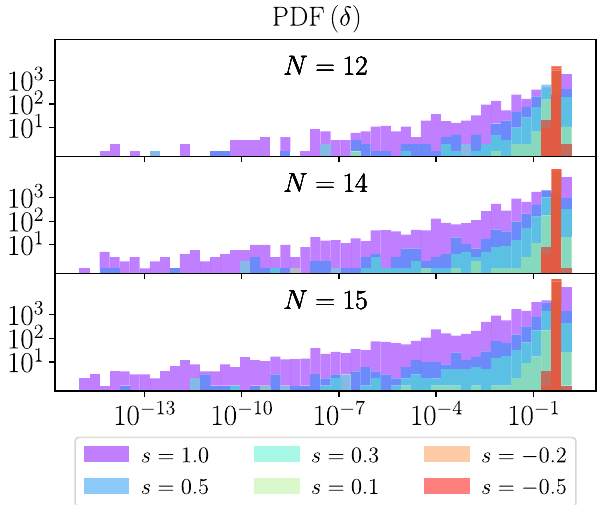
energies.FIG. 8. Probability density function of δ , log-log scale. For any given eigenstate, we compute the expectation value of the projector onto occupied site n N . As in the previous cases, the distribution is strongly peaked for negative values of s , and it develops very long tails for positive